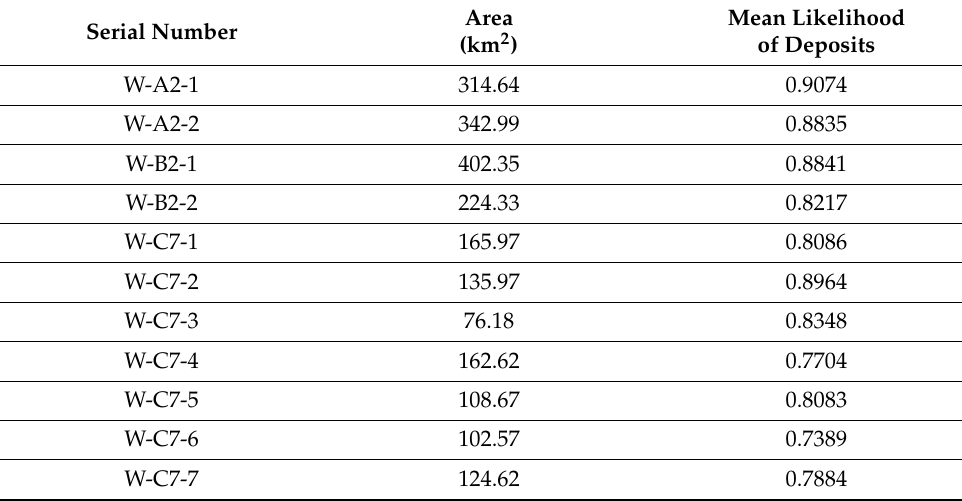
Table 9. Attributes of W prospective